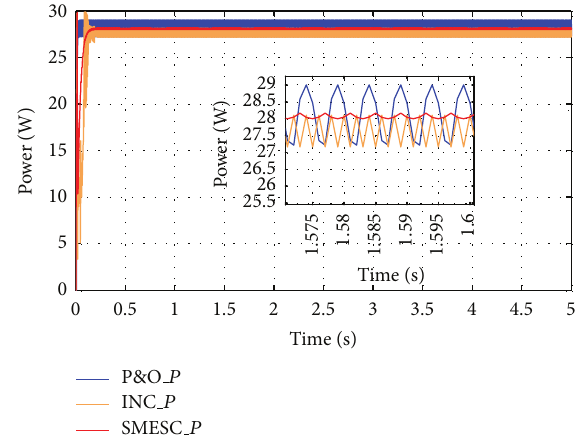
Figure 13: Simulation results for performance of P&O, INC and SMESC schemes given uniform irradiance of 1000W/m 2 .